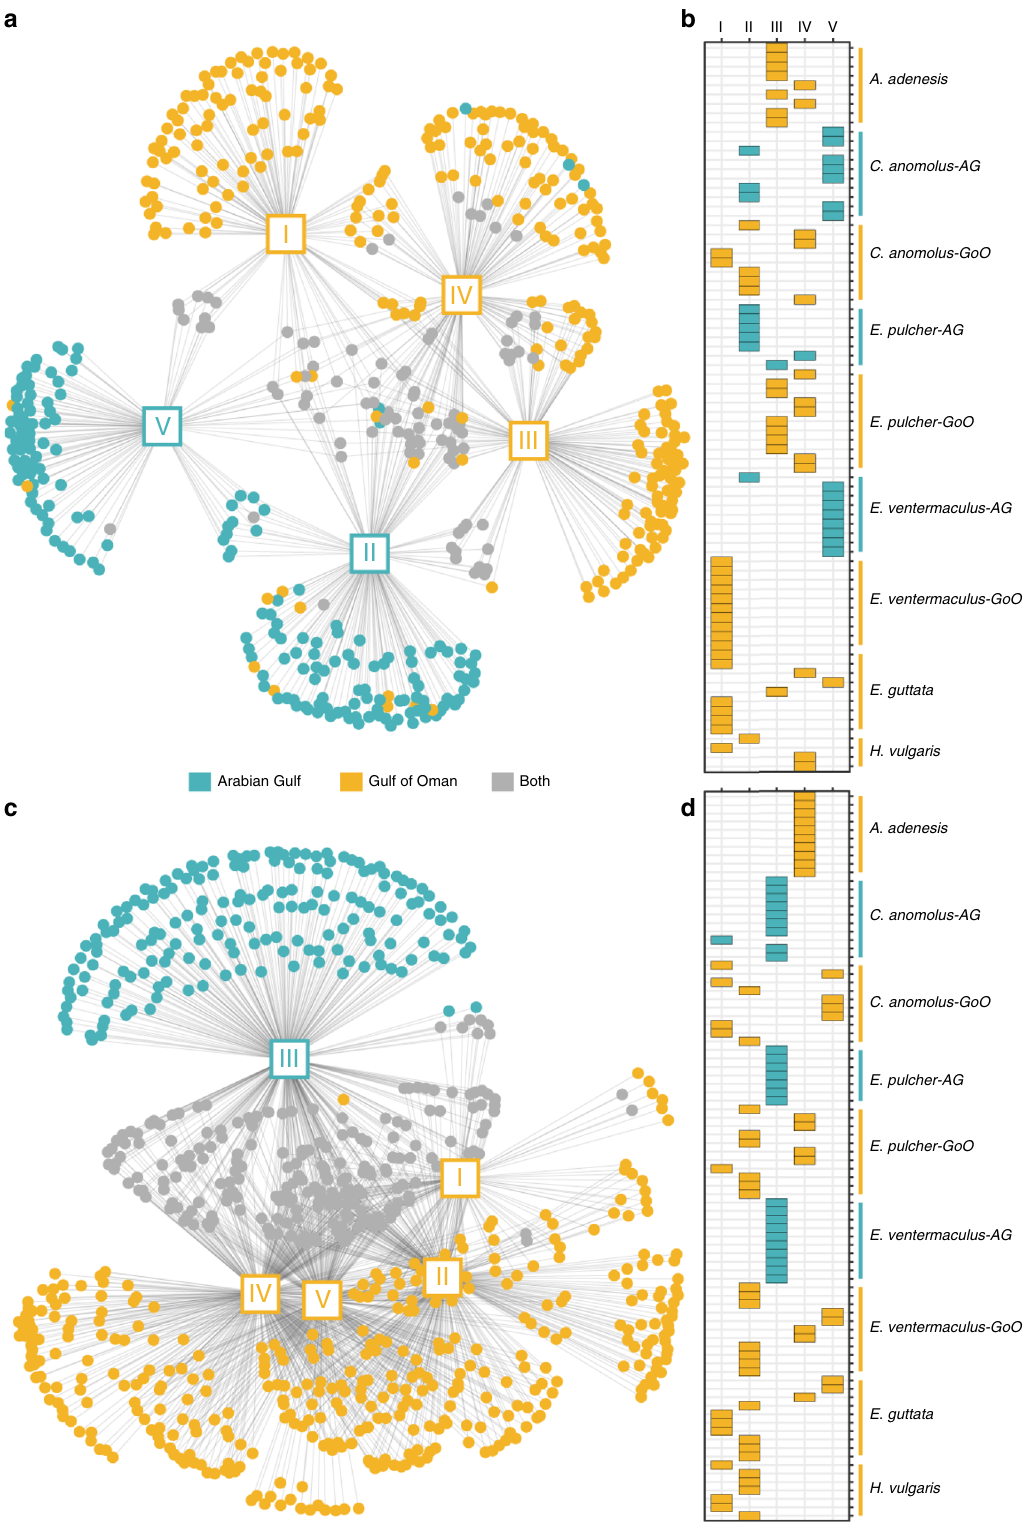
Fig. 4 Patterns of prey ingestion by cryptobenthic fi shes in the Arabian Gulf (AG) and Gulf of Oman (GoO). Diet network trees and modularity mosaics show differences in ingested prey items and individual-based module membership for COI ( a , b ) and 23S ( c , d ) markers. a , c Squares with roman numerals represent the recovered modules as nodes in the network tree, while dots represent unique prey items. Blue dots are OTUs (COI) or ESVs (23S) found only in individuals from the Arabian Gulf, gold symbols are from the Gulf of Oman individuals, and gray symbols represent prey items found in individuals from both locations. b , d Results of the modularity analysis with modules (I − V) as columns and individuals within each species as rows. Colored tiles indicate membership in a given